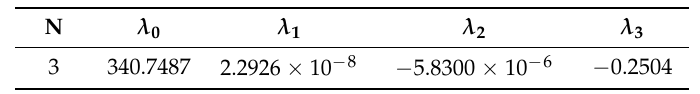
Figure 5. Relationship between original intensity and distance measurement errors (red points) and the fitted cubic polynomial (blue lines): ( a ) computer screen; ( b ) ceramic tile; ( c ) iron sheet; ( d ) polyethylene panel. σ 0 and R 2 are the fitting mean error and determination coefficient, respectively. Table 2. Parameters of the cubic polynomial.